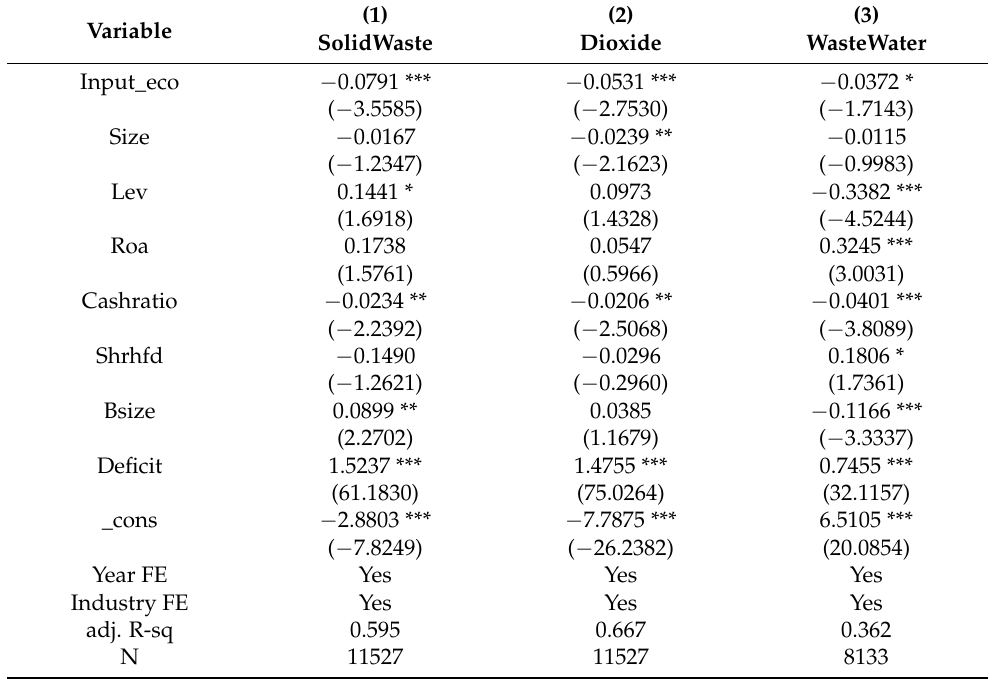
Table 9. The effects of ecological poverty